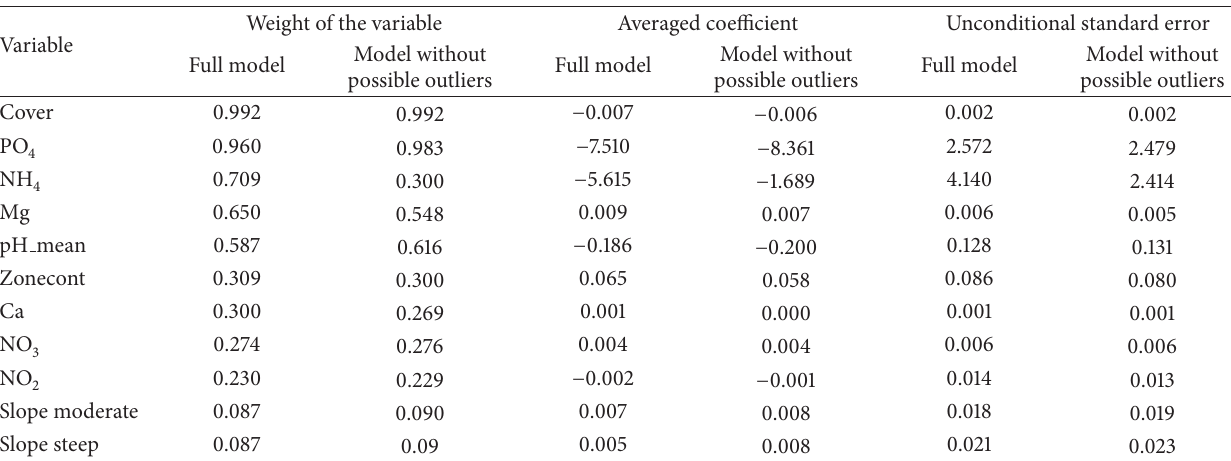
Table 3: Results of the AIC stepwise model selection for species richness showing the best significant variables selected based on their weight using the complete dataset (columns on the left) or the data without 2 possible outliers (columns on the right).